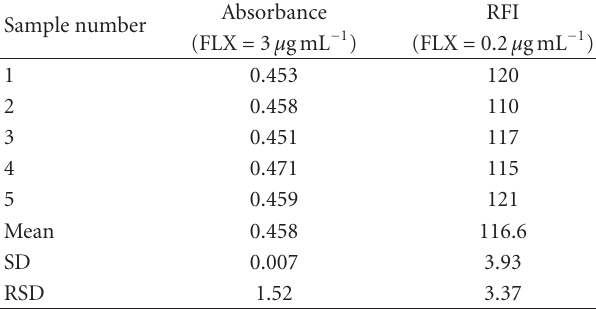
Table 3: Replicate analysis of FLX solution by the proposed spec- trophotometric and fluorimetric methods.